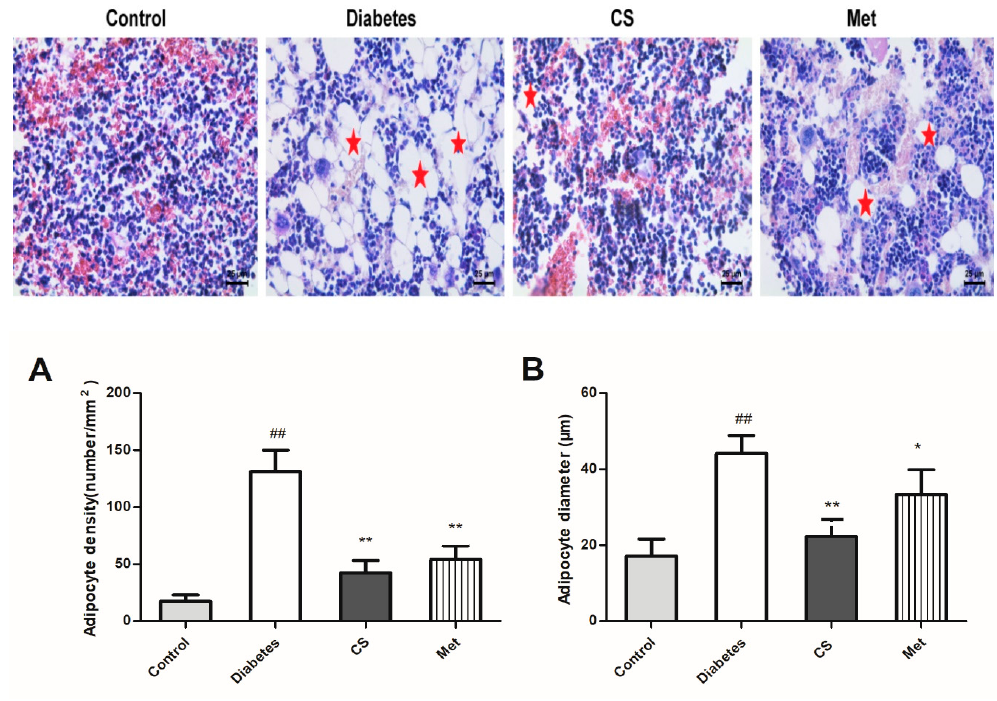
Figure 7. Adipocytes in the bone marrow cavity of the tibia, hematoxylin and eosin